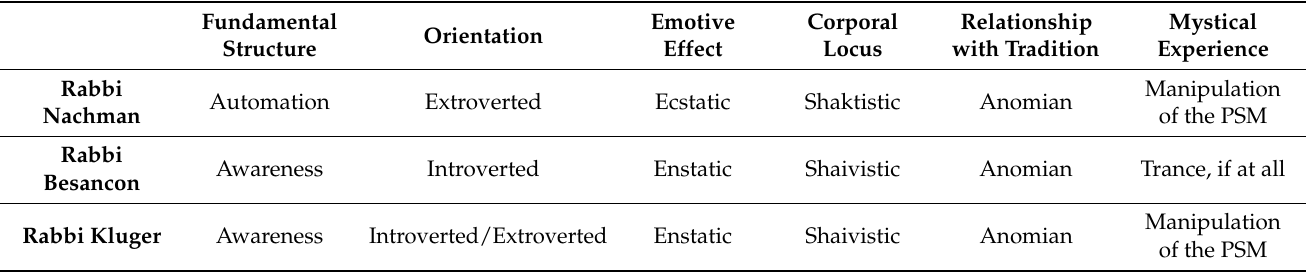
Table 3. Phenomenological Comparison of Meditative Technique and Mystical Experience in Nach- man, Besancon and